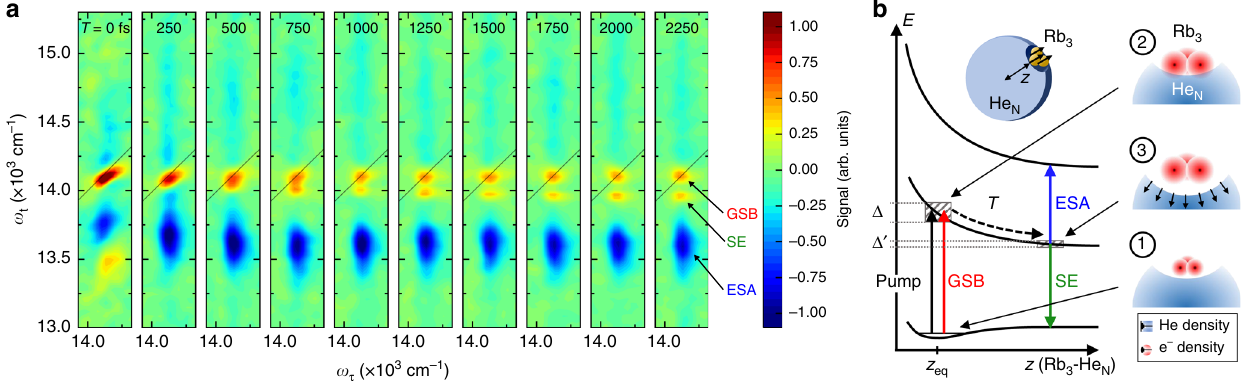
Fig. 3 Matrix-induced dynamic energy shift of the Rb 3 resonance. a Time evolution of spectral features correlated to the Rb 3 1 4 A 2 ′ ! 1 4 A 1 ; 2 ′′ excitation. For a compact presentation, only a cutout of acquired 2D spectra are shown. b Schematic of the Rb 3 -He N potentials explaining the matrix-induced dynamic shift. Step 1 – 3 sketch the expansion of the Rb 3 electron orbital upon excitation, followed by a repulsion of the helium density. In stimulated emission (SE) and excited state absorption (ESA) pathways, the system evolves on the excited state during T , leading to a dynamic red shift and peak narrowing on the probe axis, which is not present in the ground state bleach (GSB) pathway. Δ , Δ ′ indicate the change in line broadening along the ω t -axis